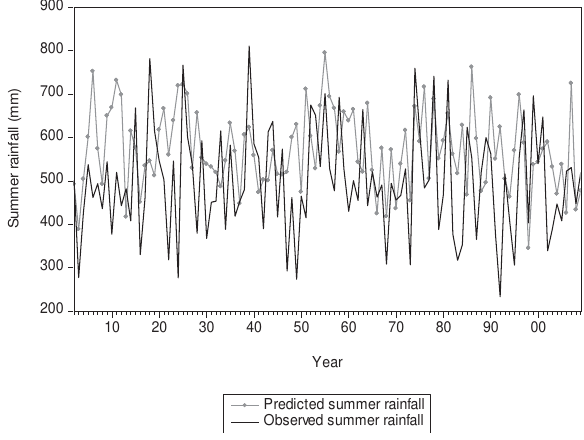
Fig. 2. Summer rainfall versus predicted rainfall